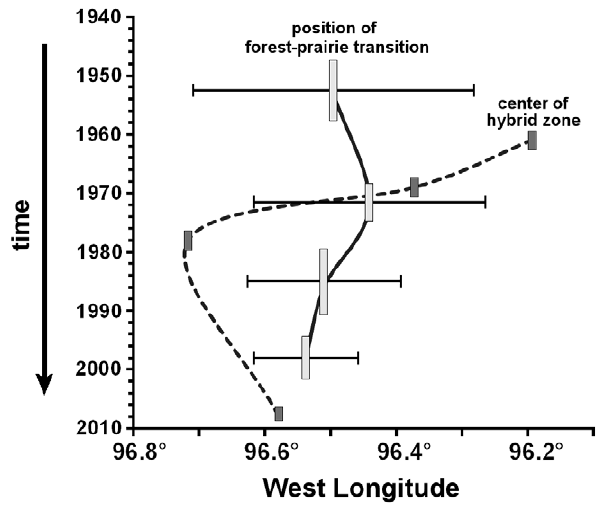
Figure 5. Geographic position (in degrees W longitude) of the centers of the clines in Cranial Crest Separation among toads and the forest-prairie transition in habitat in southeastern Manitoba, 1948–1909. Vertical bar length represents the time covered by each sampling period. Dark bars represent the center of the toads’ hybrid zone, connected by a dashed line. Light bars represent the center of the forest-prairie transition, connected by a solid line. Horizontal bars indicate the estimated width of the forest- prairie transition. doi:10.1371/journal.pone.0052819.g005 PLOS ONE |